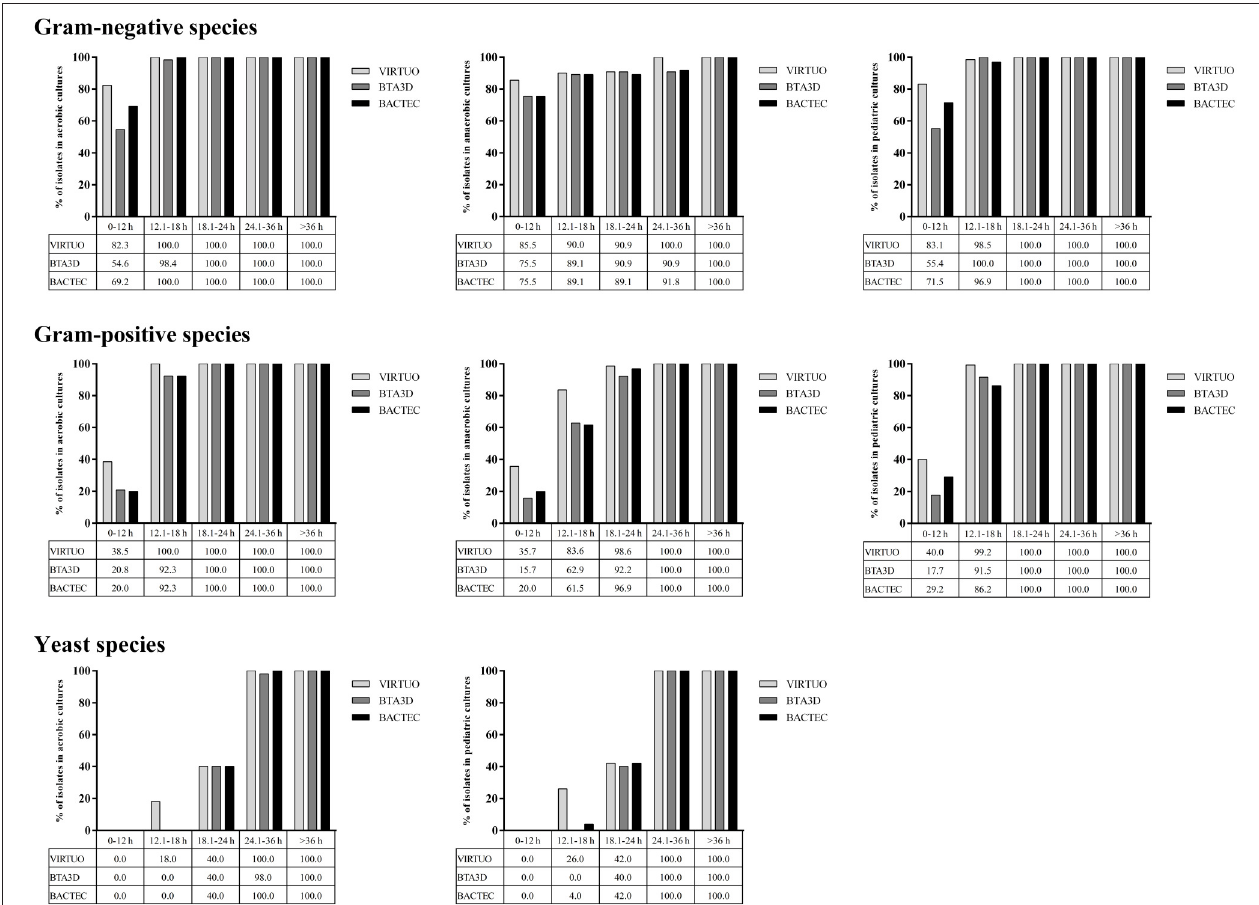
FIGURE 1 | Cumulative percentages of growth detection by BC systems in aerobic, anaerobic, or pediatric cultures of Gram-negative, Gram-positive, and yeast organisms. Human blood volumes spiked with each organism in aerobic/anaerobic (8ml) and pediatric (4ml) BACT/ALERT Plus or BACTEC FX Plus bottles for simulated adult or pediatric BCs,